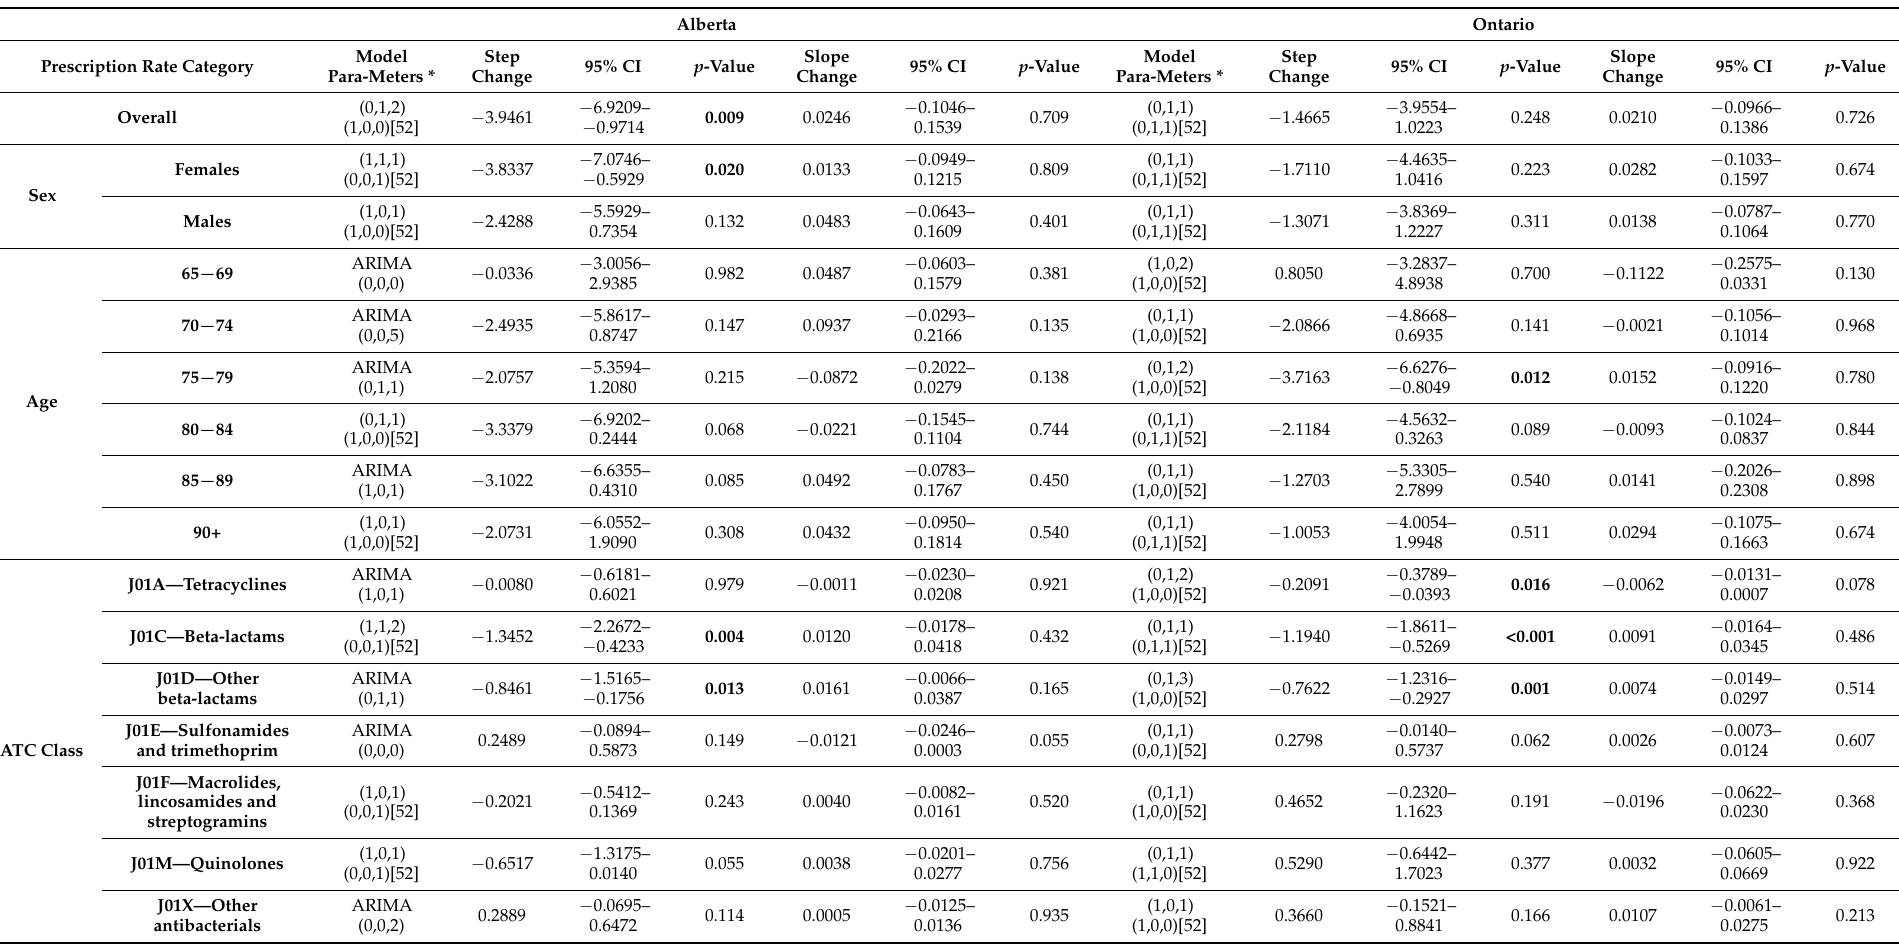
Table 3. Interrupted time series analysis showing the change in weekly oral antibiotic prescription rate per 1000 LTCF residents after March 2020 in long-term care facilities in Alberta and Ontario,